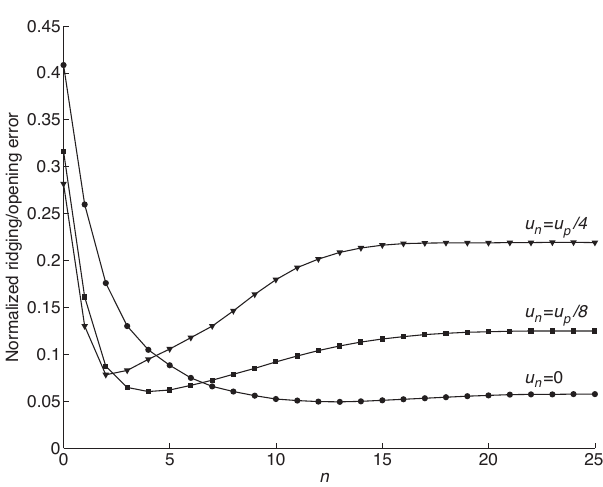
Figure 2. Root mean square closing/opening error normalized by u p and computed from 100 realizations of the single-crack (disks) and double-crack test cases (squares and triangles) at the resolution 0.1. For all curves, u p = 0 . 01.